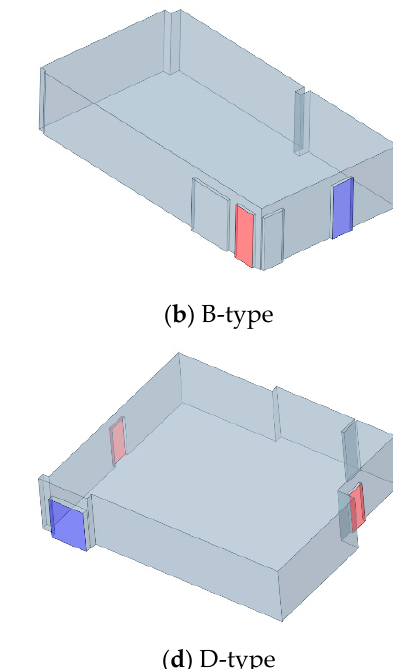
Table 3. Geometric information of target model.